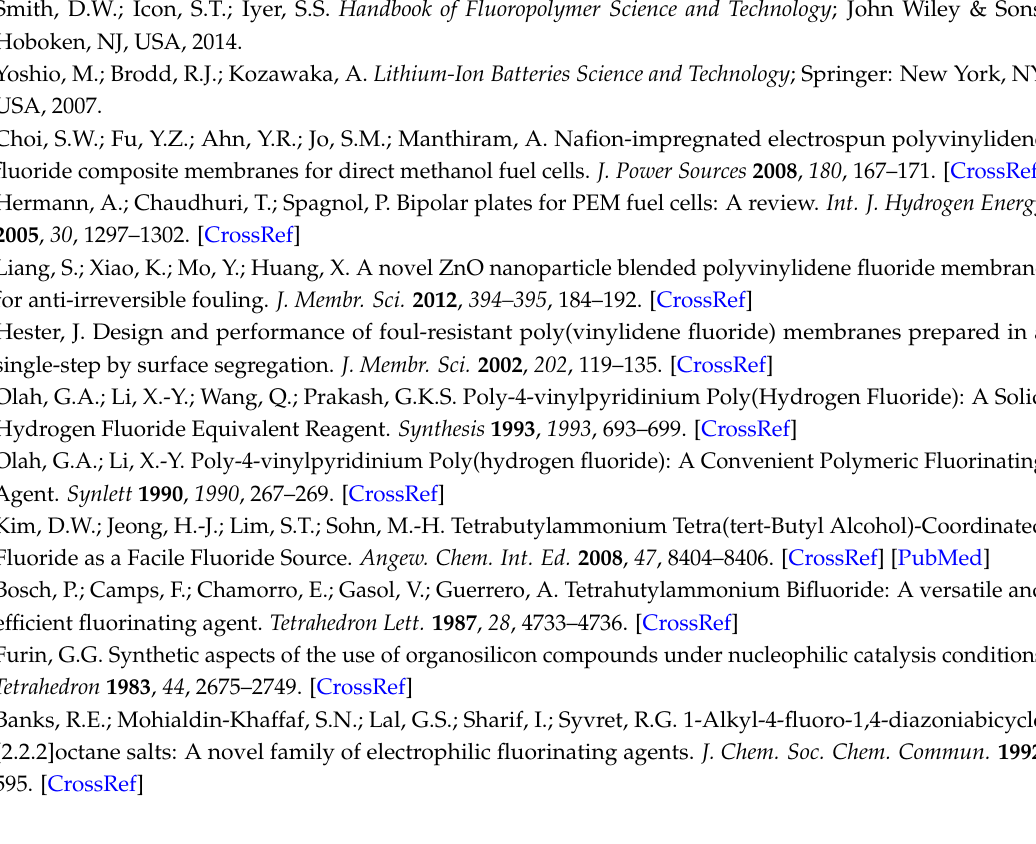
Figure S1: Conductivity depending on solvent; Figure S2: PXRD of PVP-F (with remaining starting product, before it was recrystallized) and PVAC-F; Figure S3: EDX-analysis of different electrolytes after synthesis and purification; Figure S4: Cyclovoltagrams of the different electrolytes and MeCN as reference; Figure S5: Discharge curve using carbon fiber fabric; Figure S6: Evolution of